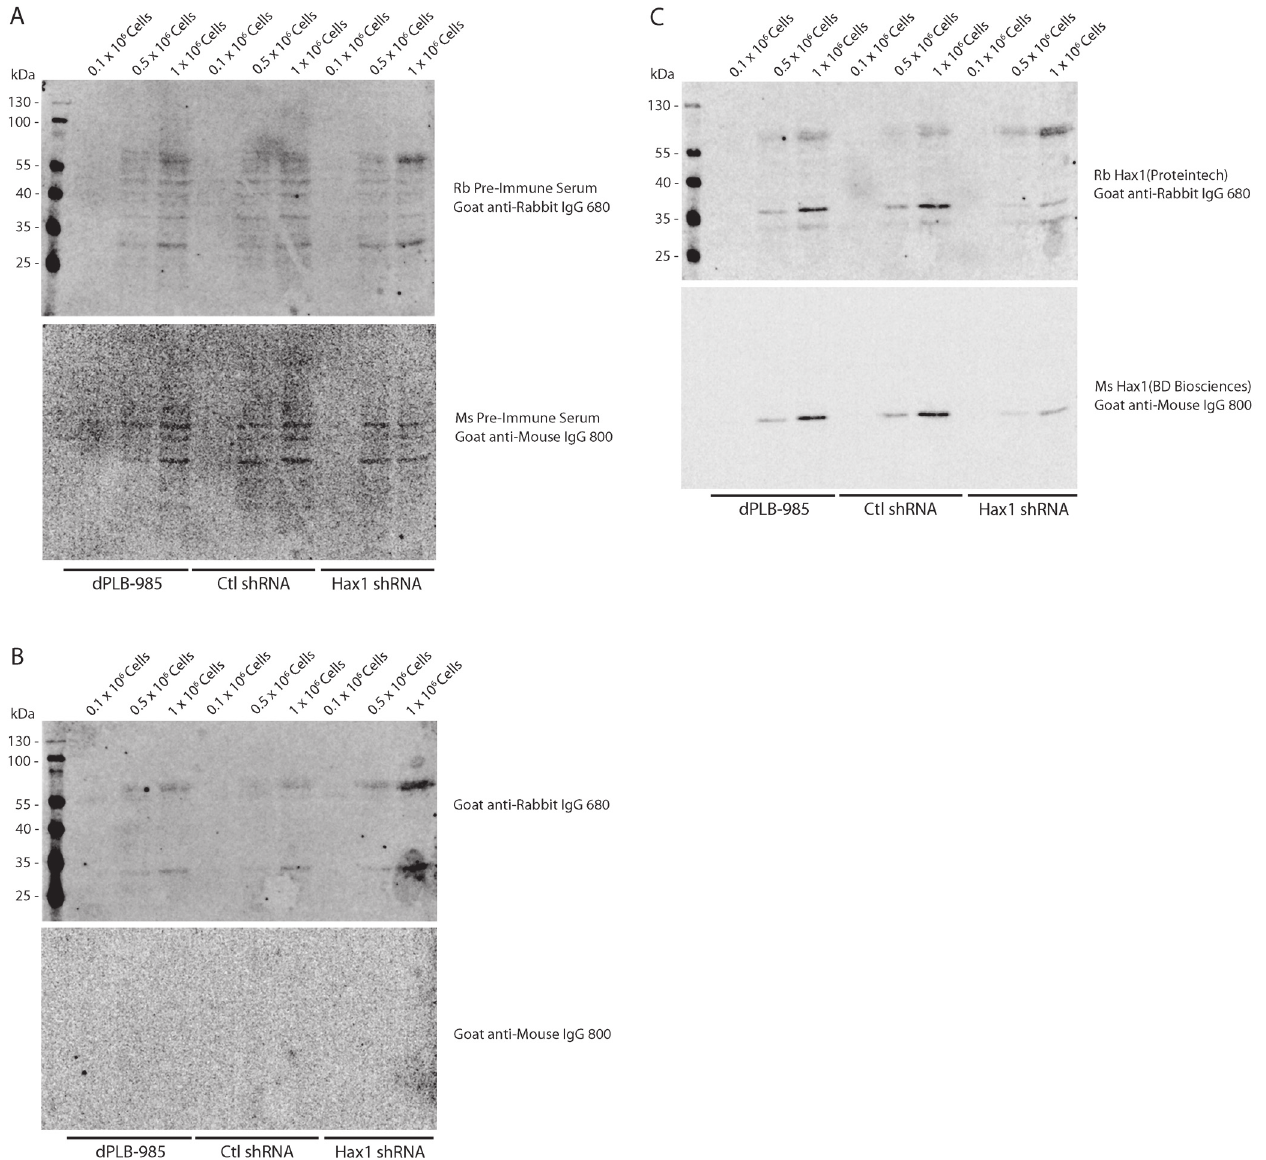
Figure 5. Goat anti-Rabbit IgG secondary antibody only background detection of differentiated PLB-985 cell lysates. ( A ) Western blot analysis using rabbit and mouse pre-immune serum from 0.1 × 10 6 , 0.5 × 10 6 , and 1 × 10 6 differentiated PLB-985, control shRNA, and Hax1 shRNA cells. ( B ) Western blot analysis using goat anti-rabbit IgG 680LT only on cell lysates from 0.1 × 10 6 , 0.5 × 10 6 , and 1 × 10 6 differentiated PLB-985, control shRNA and Hax1 shRNA expressing PLB-985 cells. Two predominant background bands can be observed at a relative mobility of 60 and 70 kDa, and one band around 30 kDa. These background bands can also be seen in Figure 1, Figure 2, and Figure 4. ( C ) Subsequent incubation with rabbit and mouse anti-Hax1 from Western blots shown in B demonstrate the appearance of the Hax1 band at the predicted 35 kDa